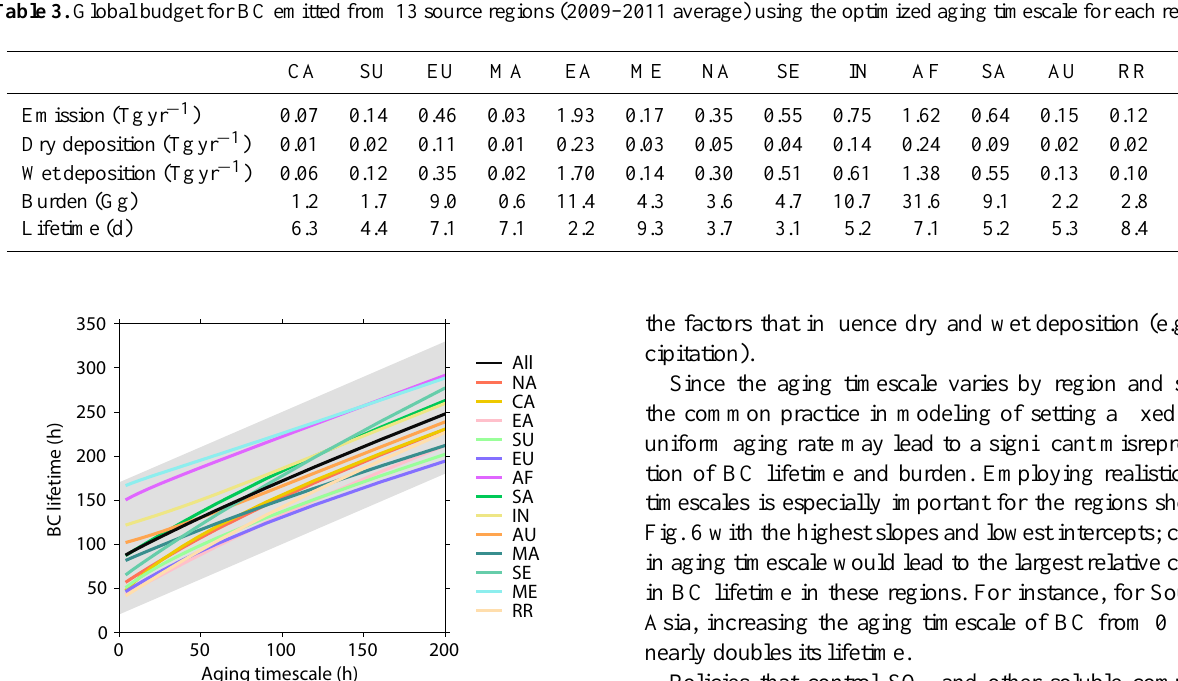
Table 3. Global budget for BC emitted from 13 source regions (2009–2011 average) using the optimized aging timescale for each region.